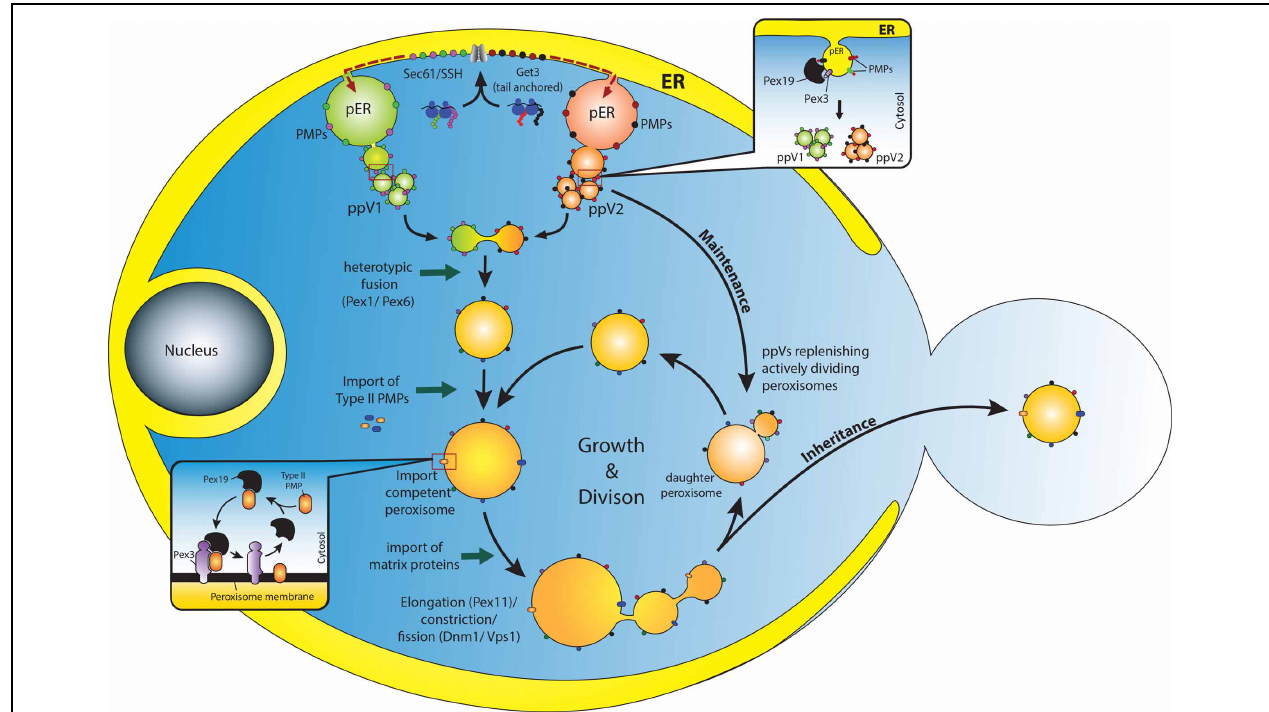
FIGURE 1 | Overview of peroxisome biogenesis: converging de novo and growth and division models. PMPs are translated in the cytosol on free ribosomes and are incorporated into the ER membrane through specific translocons (Sec61 or Get3) (van der Zand et al., 2010; Borgese and Fasana, 2011). It is assumed that the PMPs are segregated and sorted (presumably, through an intramolecular signal) into at least two different pre-peroxisomal compartments (pER) in the ER (Fakieh et al., 2013). These PMPs leave the ER through vesicular carriers that bud in a Pex19 dependent manner (upper inset) (Lam et al., 2010; Agrawal et al., 2011). These vesicles undergo heterotypic fusion to unite the components of the importomer to form import competent peroxisomes (van der Zand et al., 2012), a process that requires the Pex1 and Pex6 proteins (Titorenko et al., 2000). It is expected that Type II PMPs are incorporated at this stage since they are essential for the import of matrix